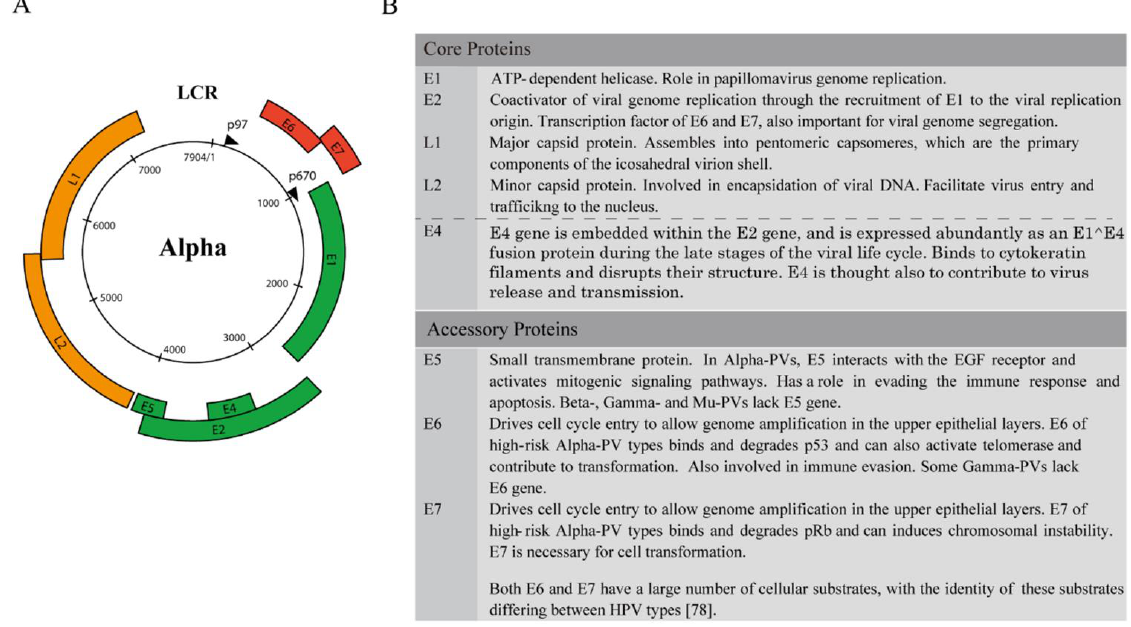
Figure 3. Alphapapillomavirus genome organization and the function of HPV proteins.